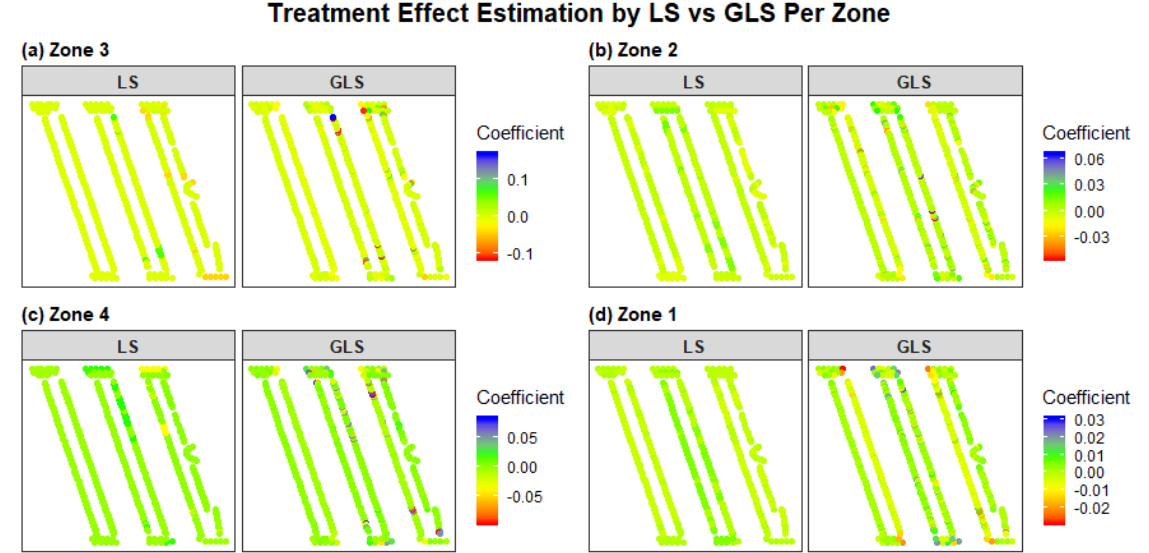
Figure 7. Spatial distribution of coefficients for estimating treatment effect of N treatment per yield stability-based management zone (Zone 1, 2, 3, and 4) via the least squares method (LS) and generalized least squares (GLS) method for Field A. Coefficients for LS were calculated by solving (𝑋 (cid:3021) 𝑋) (cid:2879)(cid:2869) 𝑋 (cid:3021) and for GLS by solving (𝑋 (cid:3021) Σ (cid:2879)(cid:2869) 𝑋) (cid:2879)(cid:2869) 𝑋 (cid:3021) Σ (cid:2879)(cid:2869) , where X represents the design matrix and Σ the spatial covariance.